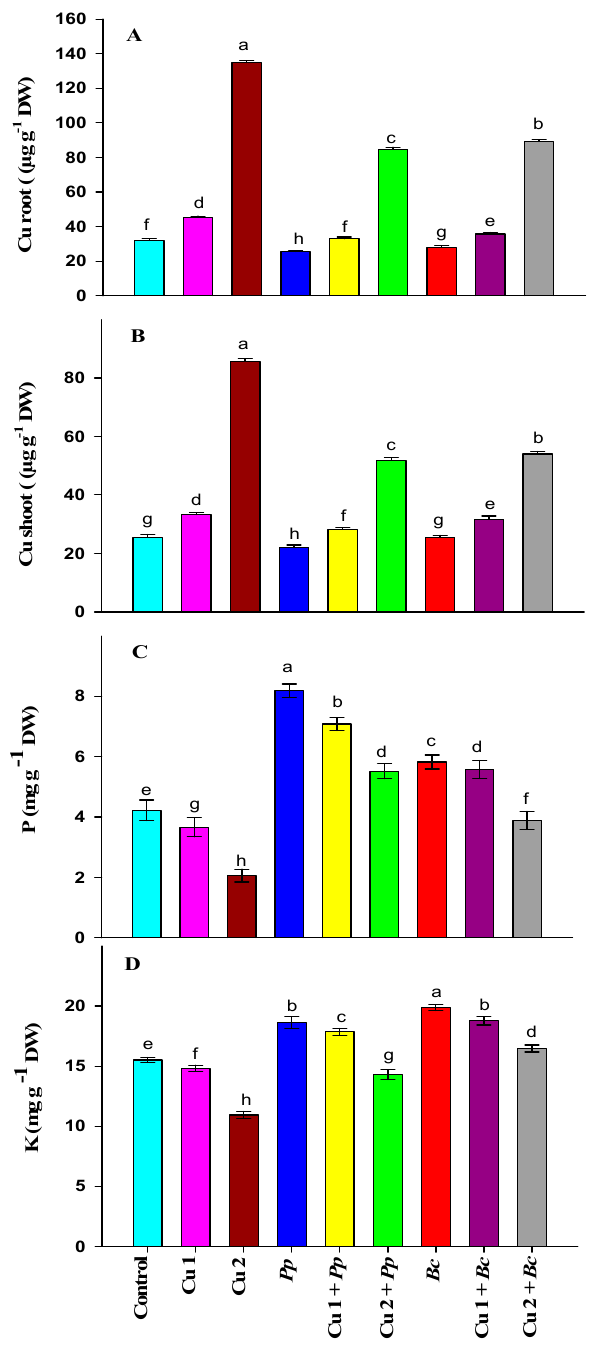
Figure 1. Effects of bacterial inoculation under copper stress on ( A ) copper in root ( B ) copper in shoot ( C ) phosphorous (P) and ( D ) potassium (K) in maize plants. Bars represent the standard deviation (±SD) of the means ( n = 3). Different letters indicate significant differences among the treatments at p ˂ 0.05, according to Duncan’s multiple range test. The treatments include Control, plants without copper stress and bacterial strains inoculation; Cu 1: plants exposed to 100 µM CuSO 4 ; Cu 2: plants exposed to 500 µM CuSO 4 ; P. polymyxa ( Pp ) inoculated plants without CuSO 4 ; Cu 1 + Pp : plants exposed to 100 µM CuSO 4 and inoculated with P. polymyxa ; Cu 2 + Pp : plants exposed to 500 µM CuSO 4 and inoculated with P. polymyxa ; B. circulans ( Bc ) inoculated plants without CuSO 4 ; Cu 1 + Bc : plants exposed to 100 µM CuSO 4 and inoculated with B. circulans and Cu 2 + Bc : plants exposed to 500 µM CuSO 4 and inoculated with B. circulans .